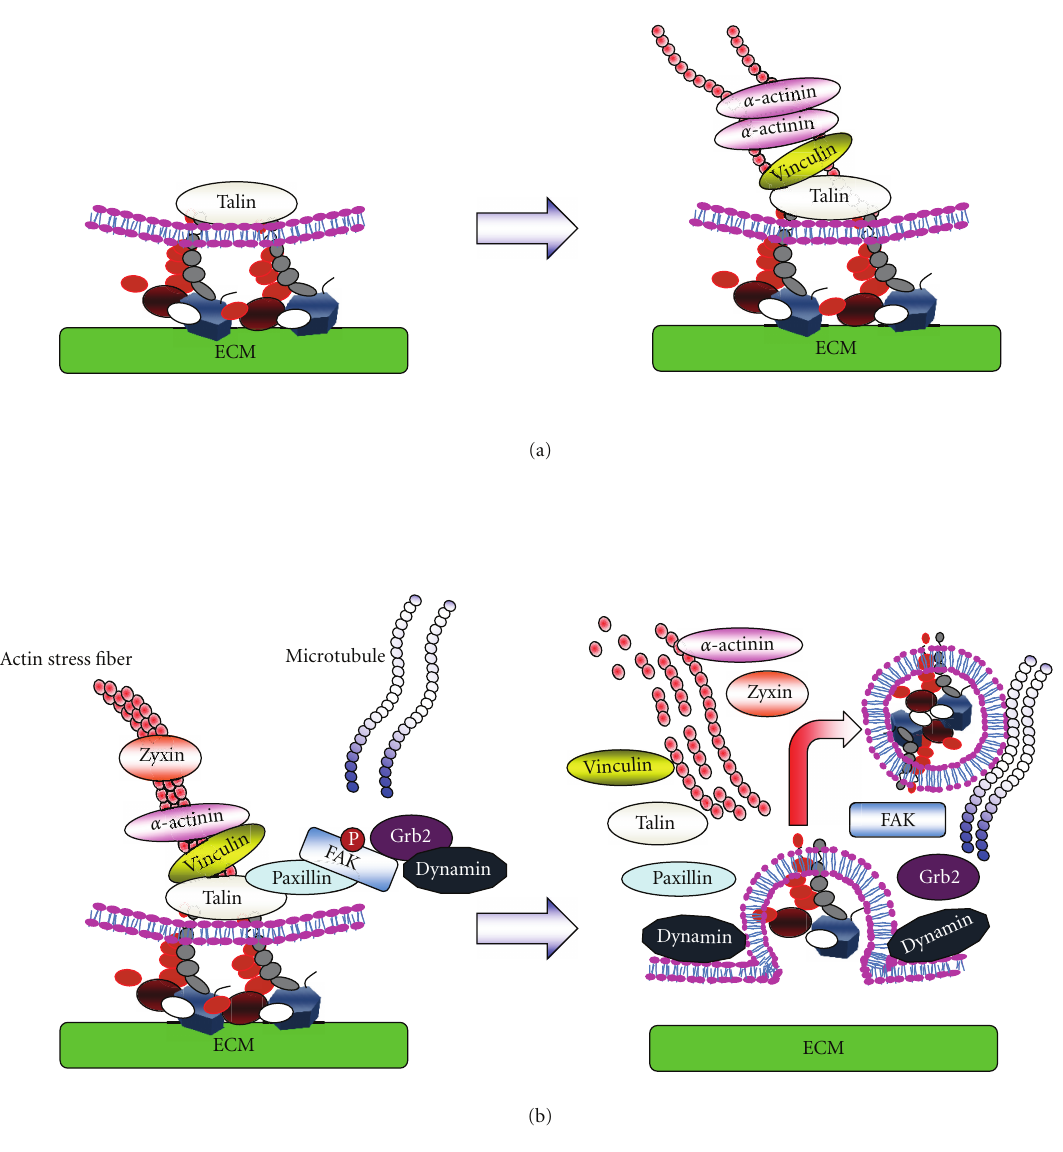
Figure 3: Formation and turnover of FAs. (a) The process of the formation of FAs. Attachment of cells to the ECM induces clustering of integrins at the attachment sites. Clustered integrins recruit cytoplasmic adaptor proteins such as talin to the cytoplasmic portion of the integrins. Actin-binding proteins such as vinculin and α -actinin then bind to talin and connect the ECM structure to the cytoskeleton via integrin. (b) The process of FA turnover. FAK phosphorylated at Tyr 397 plays a role in recruiting the endocytosis regulator dynamin into FAs via interaction with the adaptor protein Grb2. The extension of MTs initiates the internalization of integrins in a dynamin-dependent man- ner. During the process of integrin endocytosis, rapid dephosphorylation of FAK at Tyr 397 is observed.